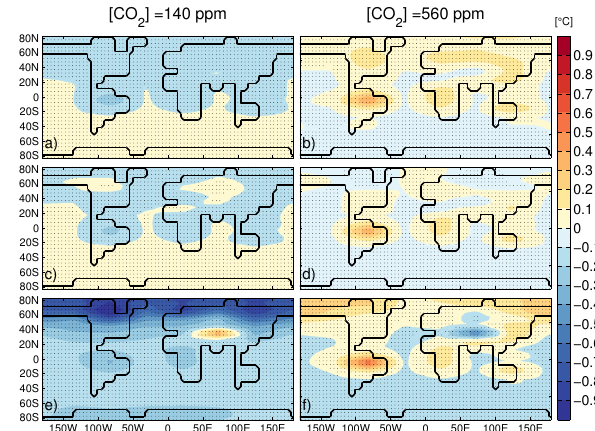
Fig. 6. Ensemble mean annual temperature anomalies relative to R for RP (top), RPL (middle) and RPLV (bottom) experiments for CO 2 of 140ppm (left) and 560ppm (right). Dots indicate areas where values are significant at the 95% level.